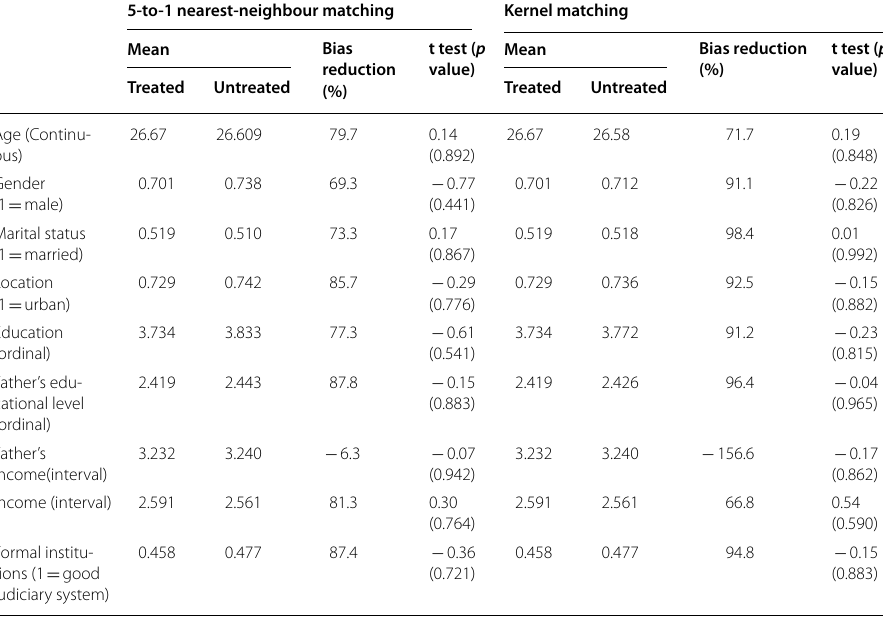
Standard errors are reported in the parentheses